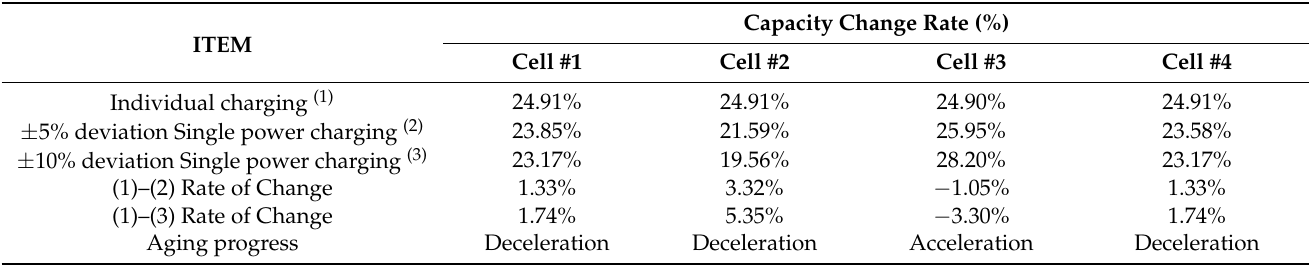
Table 5. Progression of aging in series-connected cells with different capacities. The simulation time for each condition was the